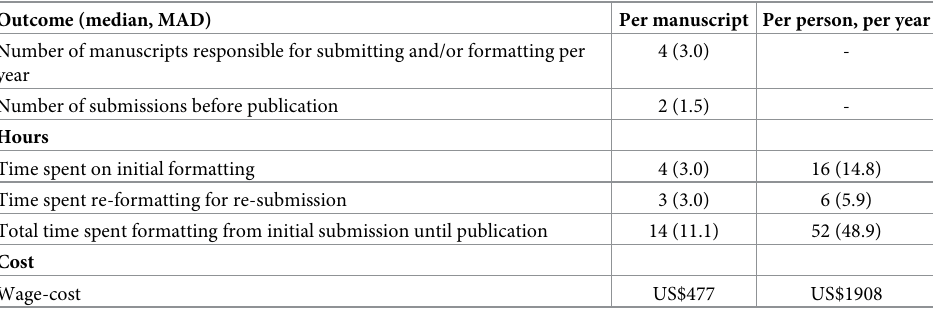
Table 2. Outcomes related to cost of formatting for scientific publications. Outcome (median,